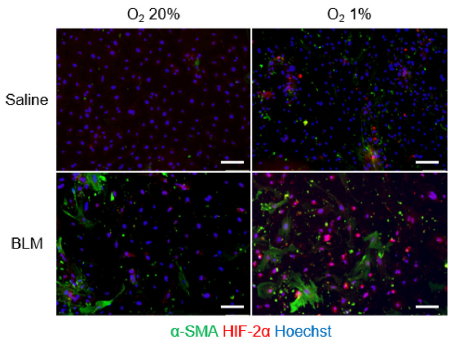
Figure 7. Hypoxia-induced co-expression of HIF-2 α and α -SMA in endothelial cells. Representative fluorescence microscopy images of endothelial cells from saline- and bleomycin-treated lungs, cultured under normoxic (20%) and hypoxic (1%) conditions. The HIF-2 α (red) and α -SMA (green) stained images were merged with those showing a nuclear stain (Hoechst, blue). Scale bars indicate 100 μ m.